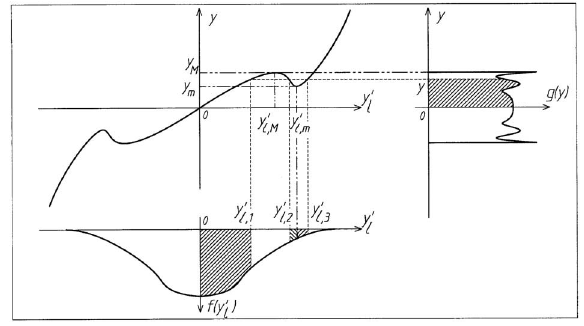
FIG. 7. A geometrical representation of the transverse density mapping upon polynomial transform Eq. (1), and of the integral Eq.